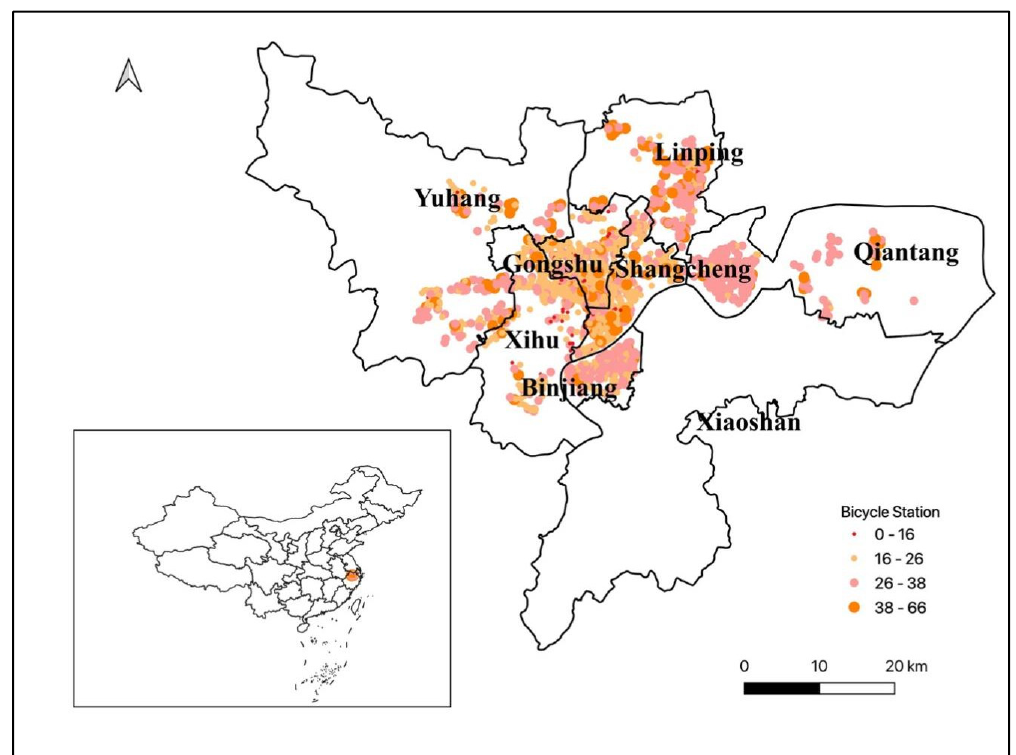
Figure 1. Hangzhou public bicycle system in 2019. The administrative boundary of Hangzhou changed in 2020.